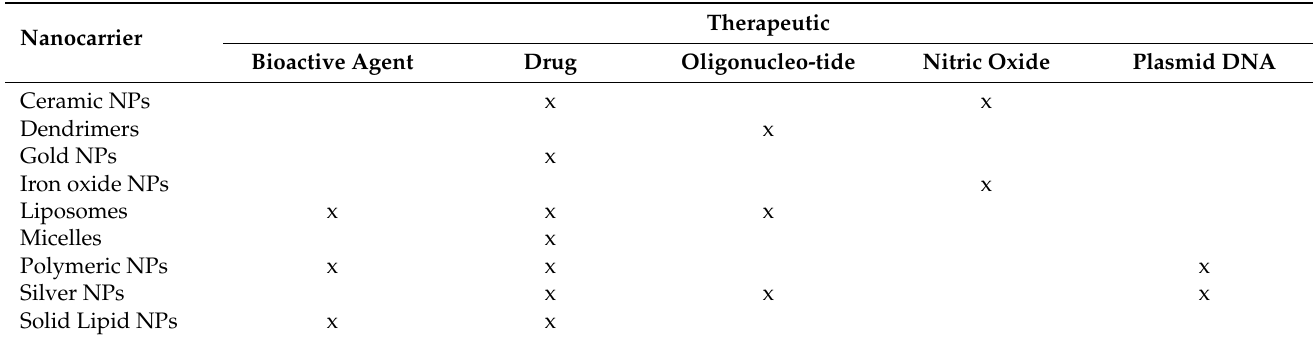
Table 2. Various therapeutics delivered by nanocarriers in wound healing therapies, according to Barroso et al. [181]. Key to symbols: NPs—Nanoparticles.